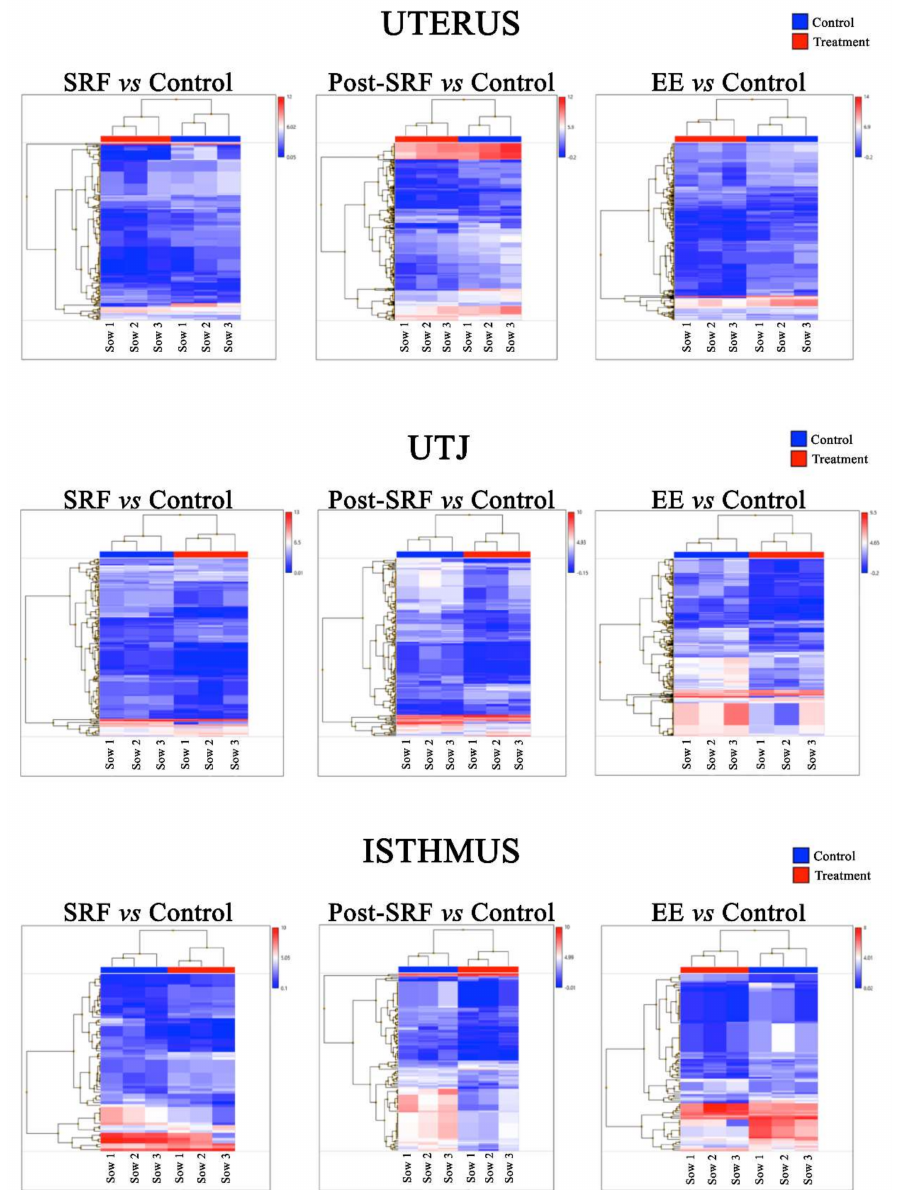
Figure 1. Hierarchical clustering of the di ff erentially expressed microRNAs (miRNAs) ( p -value < 0.05 and ≥ 2.0-Fold Change (FC) or ≤− 2.0) in media of each cultured explant (uterus, utero-tubal junction (UTJ) and isthmus) exposed to di ff erent treatment (Medium 199 (M199) supplemented with seminal plasma from di ff erent ejaculate fractions (sperm-rich fraction (SRF) and post-SRF) and from the entire recomposed ejaculate (EE)) compared with its control (C, M199 alone), showed a clear distinction between control and treatments in the three sows. The color scale indicates the relative expression of miRNAs: red shows higher expression and blue lower expression. Each row represents one miRNA and each column represents a tissue